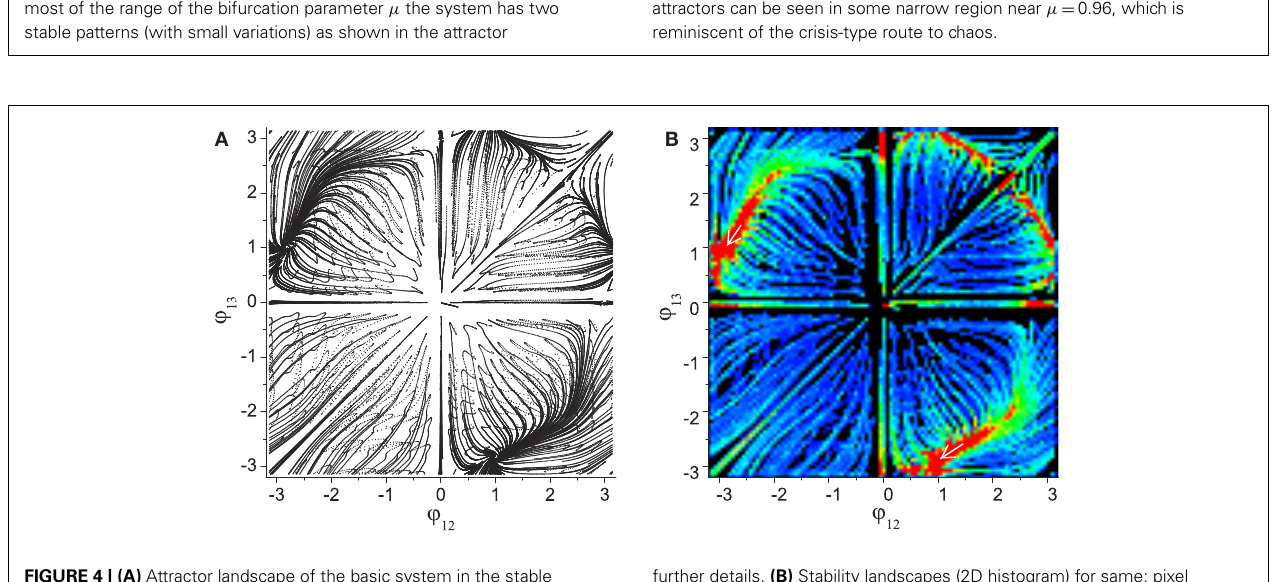
FIGURE 4 | (A) Attractor landscape of the basic system in the stable regime where the reflex weights are homosynaptically set to 1.The diagram shows phase relationships between two different sets of CPGs for the simple biomechanical model. Each axis represents the phase difference between the outputs of CPGs 1–2 and 1–3. See text for